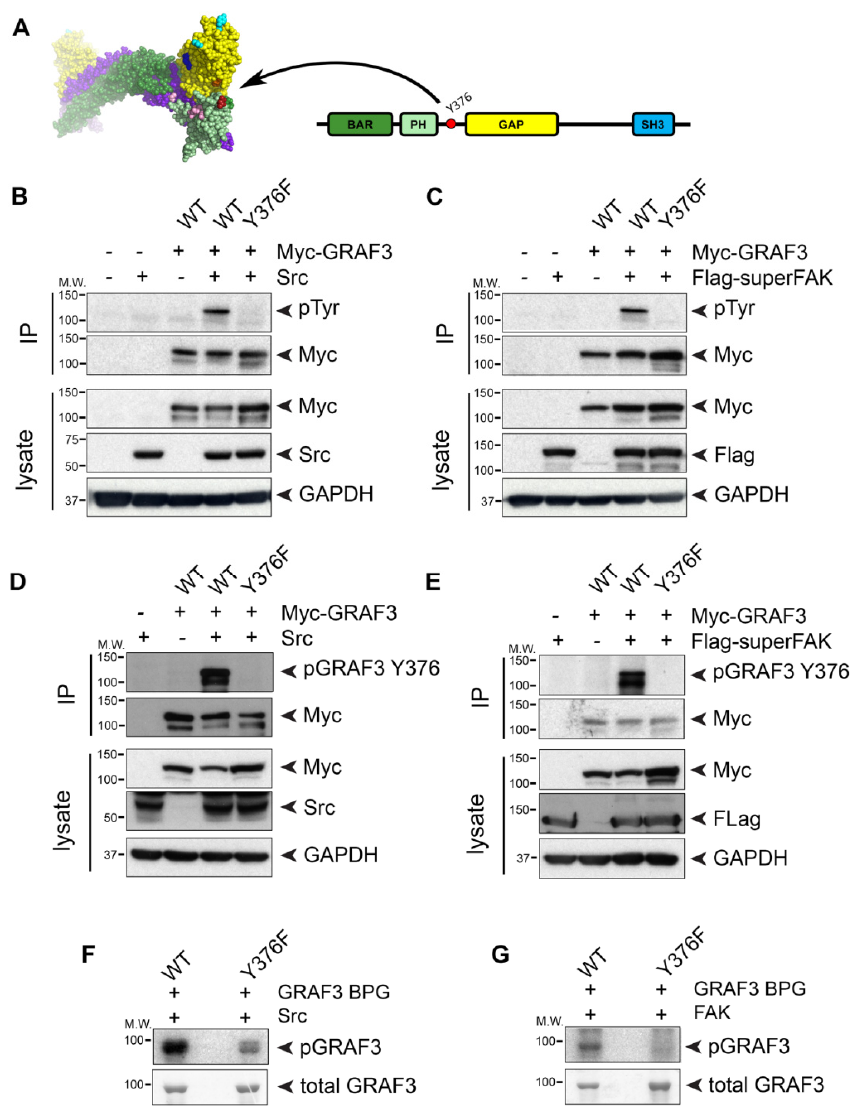
Figure 4. Both Src and FAK kinases phosphorylate GRAF3 at Y376. ( A ) 3-D (left) and 2-D (right) schematics of GRAF3 indicate location of Y376 in the unstructured, un-modeled linker between the C-terminus of the PH domain (red) and the N-terminus of the GAP domain (orange). ( B–E) Cos cells were transfected with the indicated Myc-GRAF3 variant and either ( B , D ) 529F Src (Src) or ( C , E ) Flag-superFAK cDNAs. Myc-tagged GRAF3 was immunoprecipitated from cell lysate and blots were probed with indicated antibodies. ( F , G) Purified GRAF3 BAR-PH-GAP (BPG) domain and Y376F GRAF3 BAR-PH-GAP were subjected to a radioactive kinase assay using activated ( F ) Src or ( G ) FAK and ATP γ - 32 P. Phosphorylated and total GRAF3 are shown by radiograph (top) or Coomassie Blue staining (bottom), respectively. All blots are representative of 3 independent experiments.